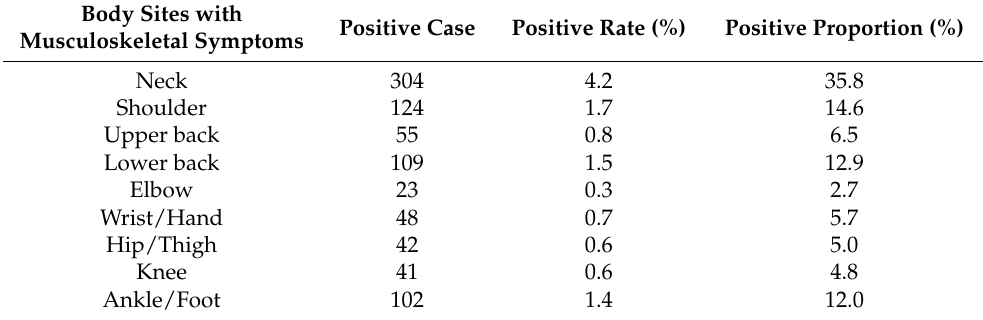
Table 5. Prevalence of only single-site musculoskeletal symptom in the past 12 month. ( n = 848). Body Sites